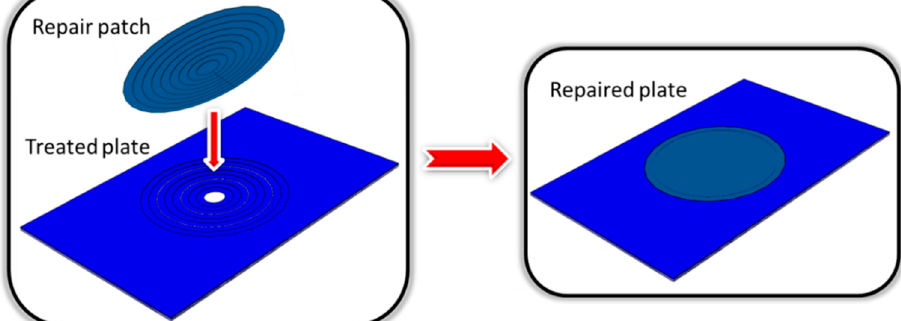
Table 2. Geometry of the laminate that was analysed.